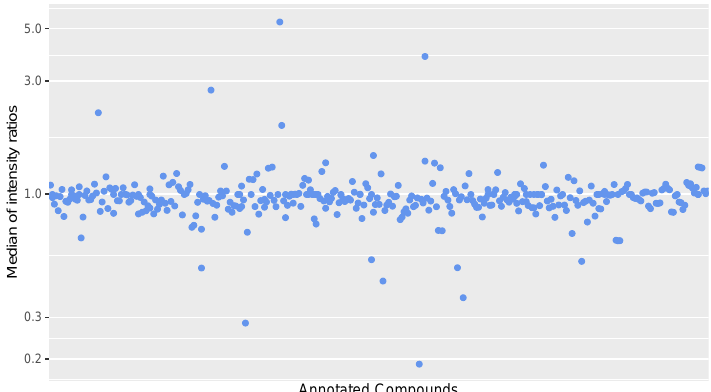
Figure A3. Scatter plot of the median of intensity ratios for each concentration level of annotated compounds in the calibration samples. The intensity ratios were calculated by dividing the intensity in the second calibration sample at a level by the intensity in the first calibration sample of that same level.